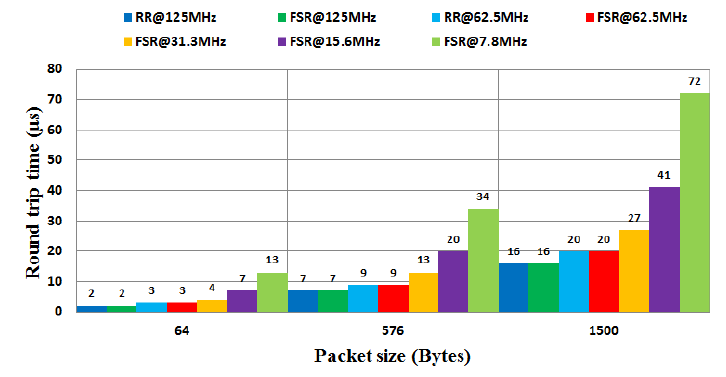
Figure 12. Round trip time of the RR and the FSR under different frequencies and packet sizes.